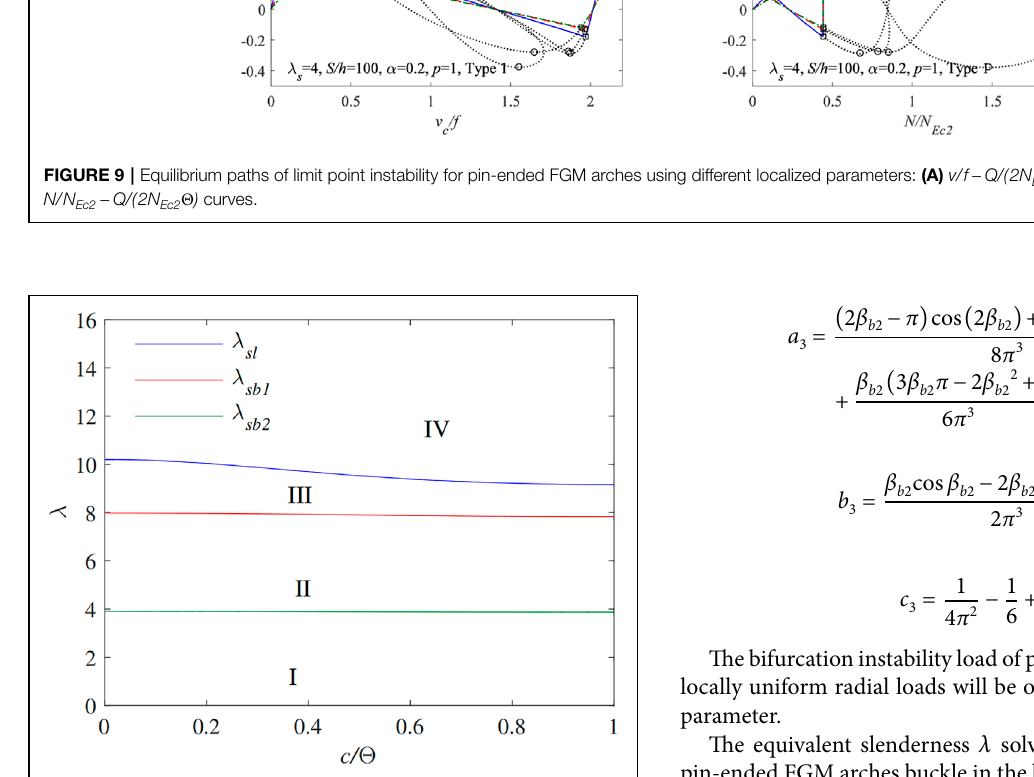
FIGURE 10 | Instability pattern for pin-ended FGM arches having different localized parameters.